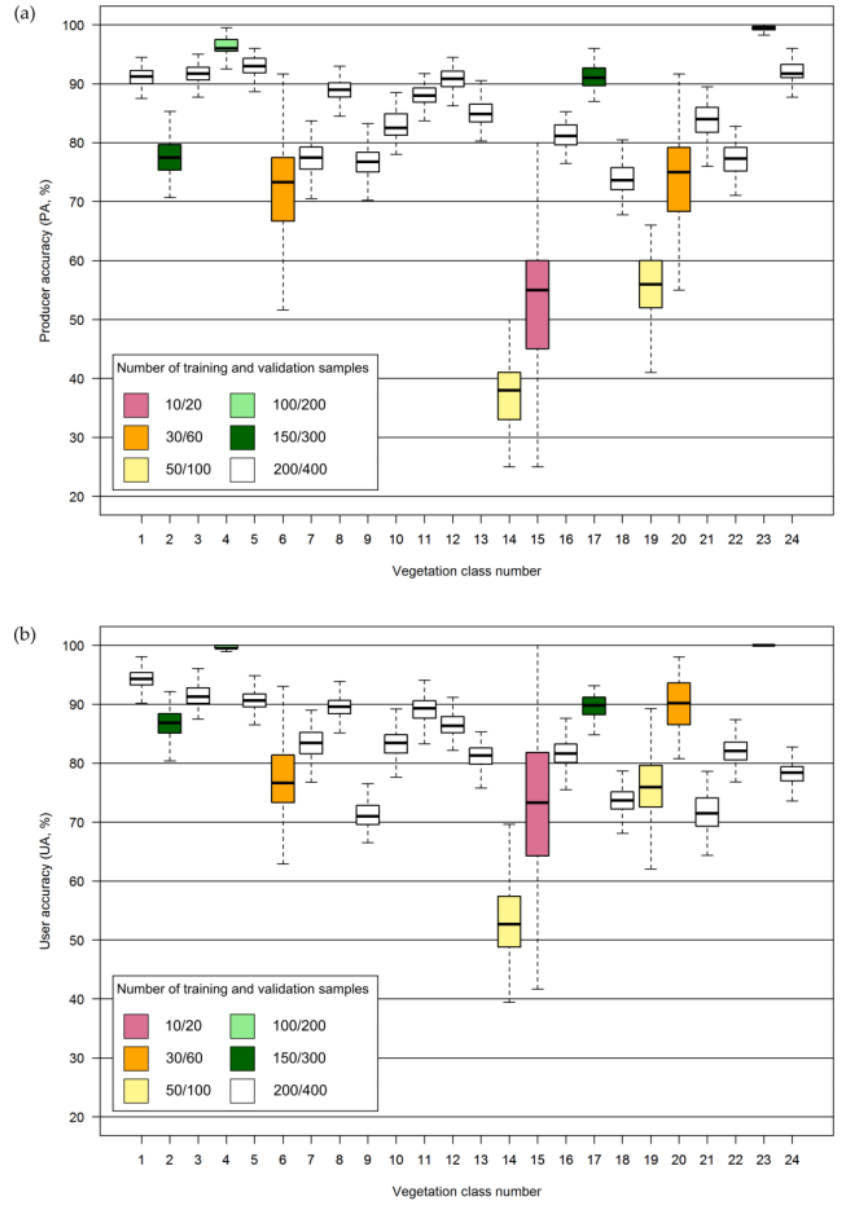
Figure 6. Accuracies for each for each class obtained during 100-fold iterative accuracy assessment: ( a ) Producer accuracies; ( b ) User accuracies. (1— Rhizocarp. alp . all., 2— Umbilic. cyl . all., 3— Carici ( rig. ) –Nard . 4— Carici (rig.)–Fest. air. (alp.), 5— Carici ( rig. ) –Fest. air . (subalp.), 6— Cardamino–Mont .